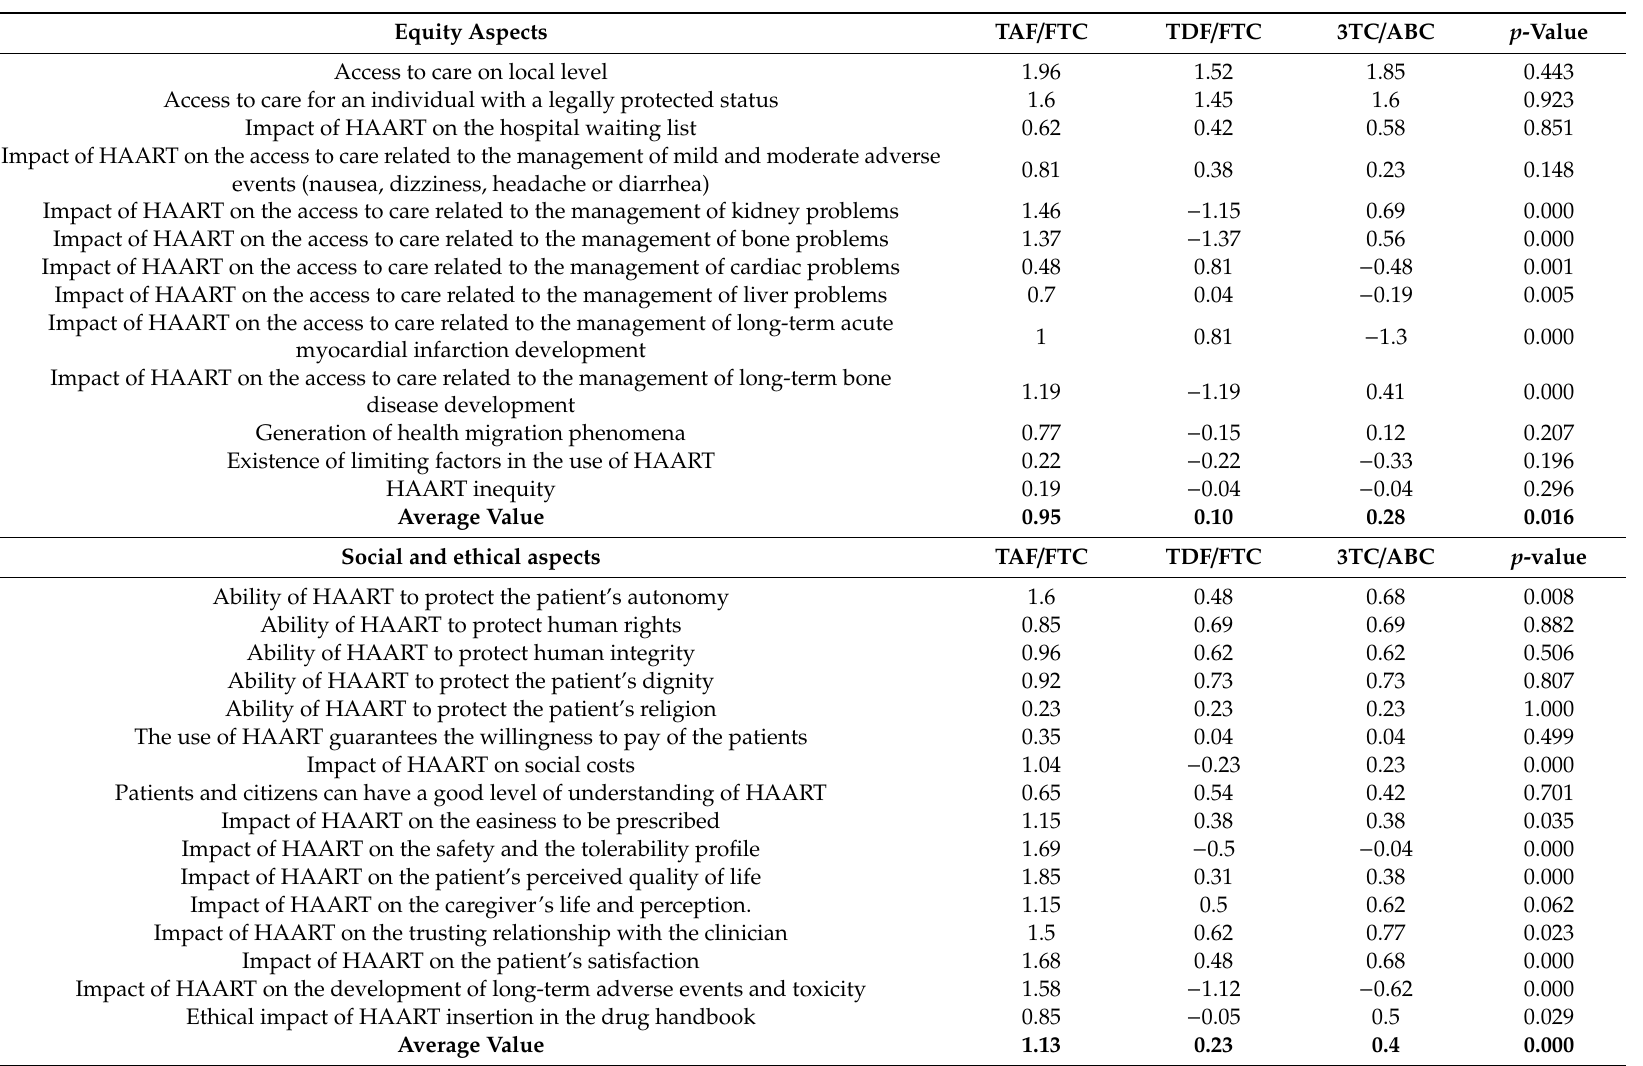
Table 8. Qualitative analysis. Source: data gathered by